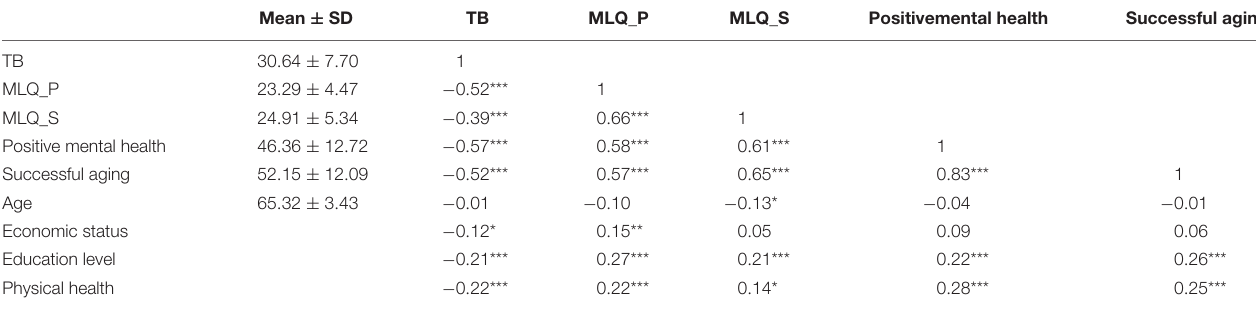
TABLE 2 | Descriptive statistics and correlations between variables.